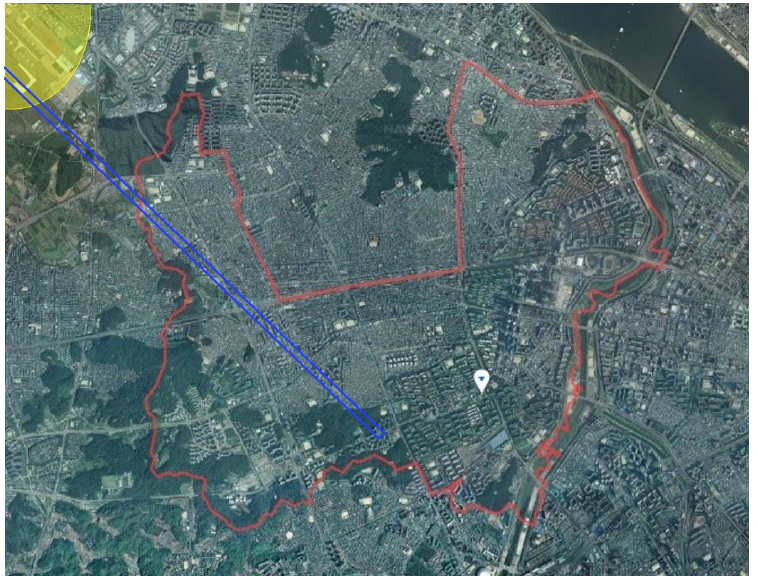
Figure 1. The research area for noise exposure, Yangcheon-Gu (red borderline); Gimpo airport (yellow area); The airway of the airport (blue